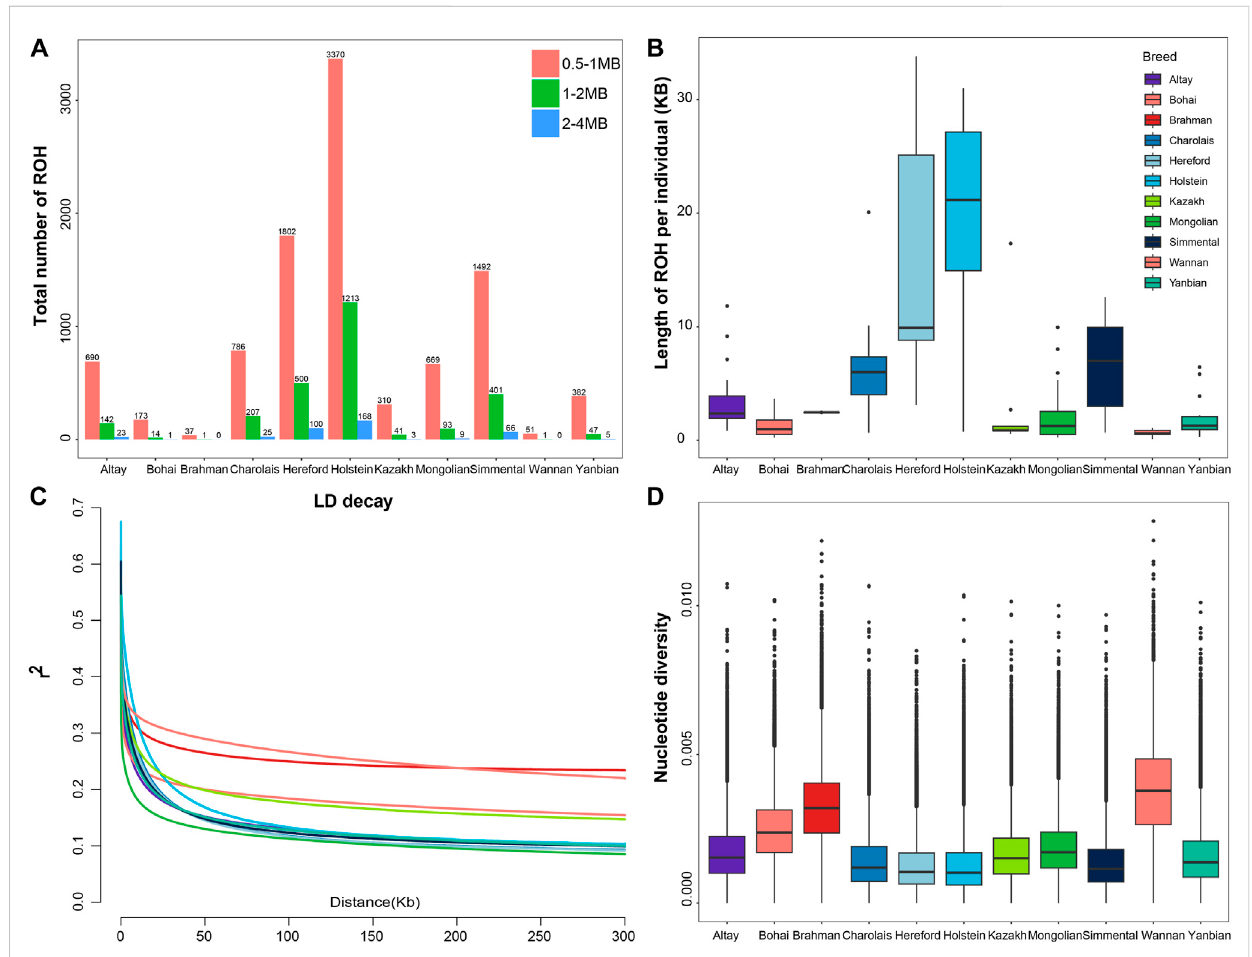
FIGURE 1 Summary of genomic variation statistics. ROH statistical distributions for 11 cattle breeds. (A) The number of ROH events in each breed. (B) The length of ROH events held by each breed. (C) Estimated genome-wide average LD decay from each breed. (D) Genome-wide nucleotide diversity distributionofeachbreedin50 kbwindows with50 kbincrements. Themedianofthedistribution isshownbythehorizontallineinside thebox.;thebox boundaries represent the fi rst and third quartiles, and the points represent outliers. Outliers are data points that fall outside the